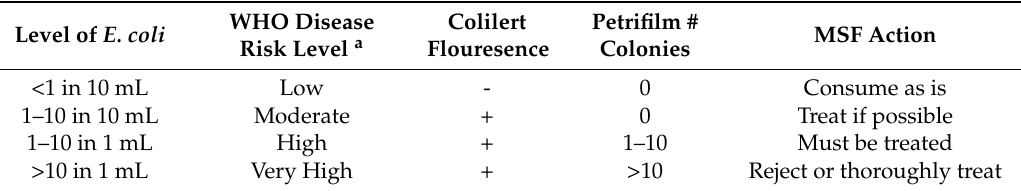
Table 3. Correspondence between Escherichia coli presence from the Colilert test, E. coli counts from the Petrifilm test, and WHO disease risk categories [56,57]. Level of E.